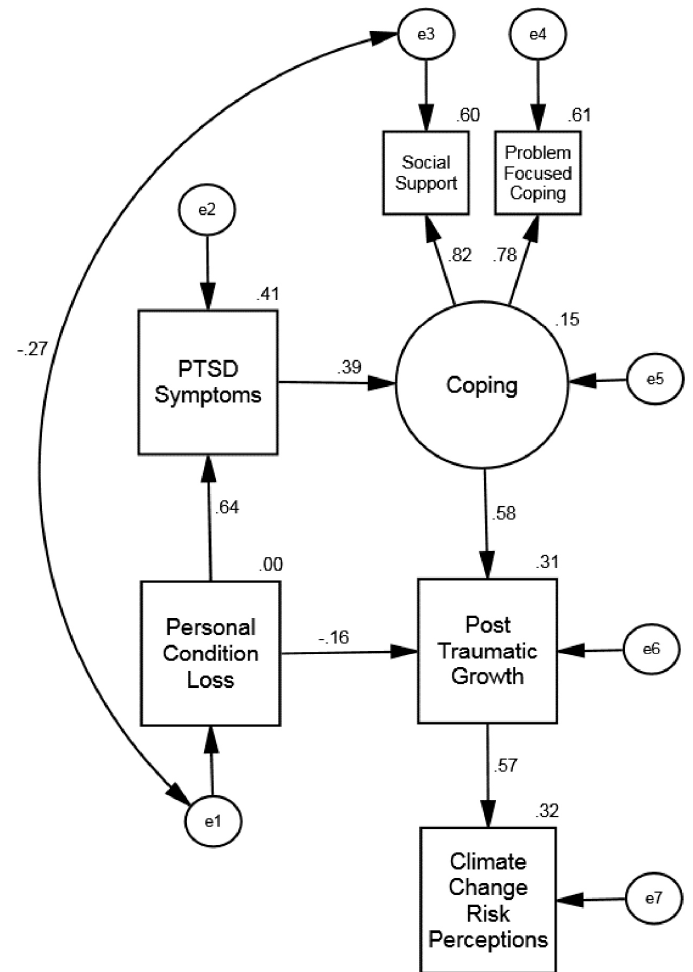
Figure 3. (Study 2: Fiji): Exploratory Sample Final Structural Equation Model: Influence of Resource Loss on Posttraumatic Symptoms, Coping, Posttraumatic Growth, and Climate Change Risk Perception. The offset values on endogenous variables are R 2 effect sizes.